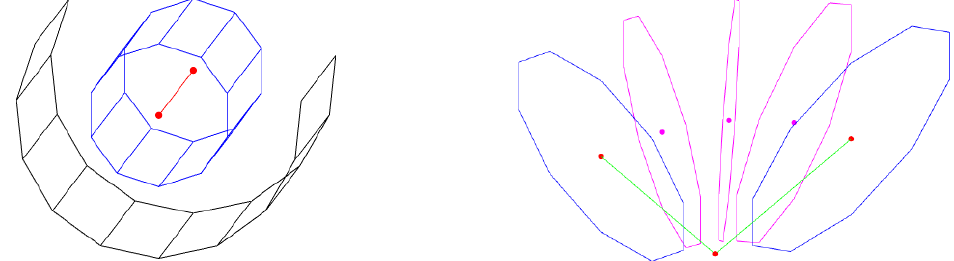
Figure 4. Generation of cylinders from a segment ( left, blue) and rounded corners between two cylinders ( right , magenta).